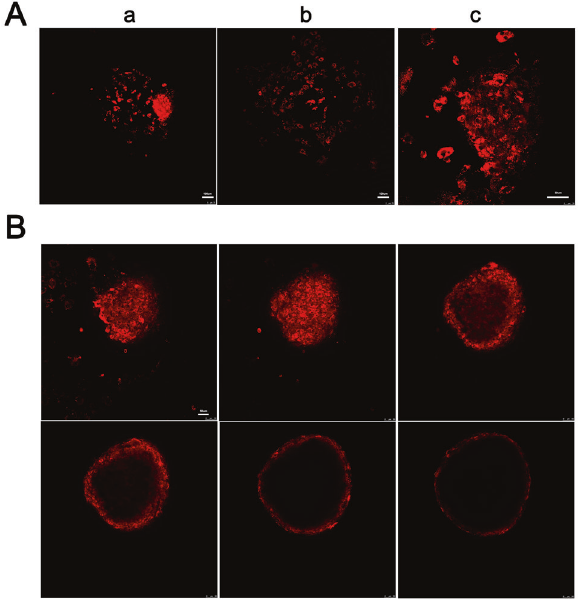
Fig. 1 Assessment of the formation of spheroids composed of ADSCs and cell viability. A IF staining showed that the spheroids composed of ADSCs had good morphology and the cells migrated from the spheroid, suggesting that the ADSCs maintained good proliferation and migration abilities after spheroid formation. B Images of different cross-sections of the spheroids revealed that the cells were evenly